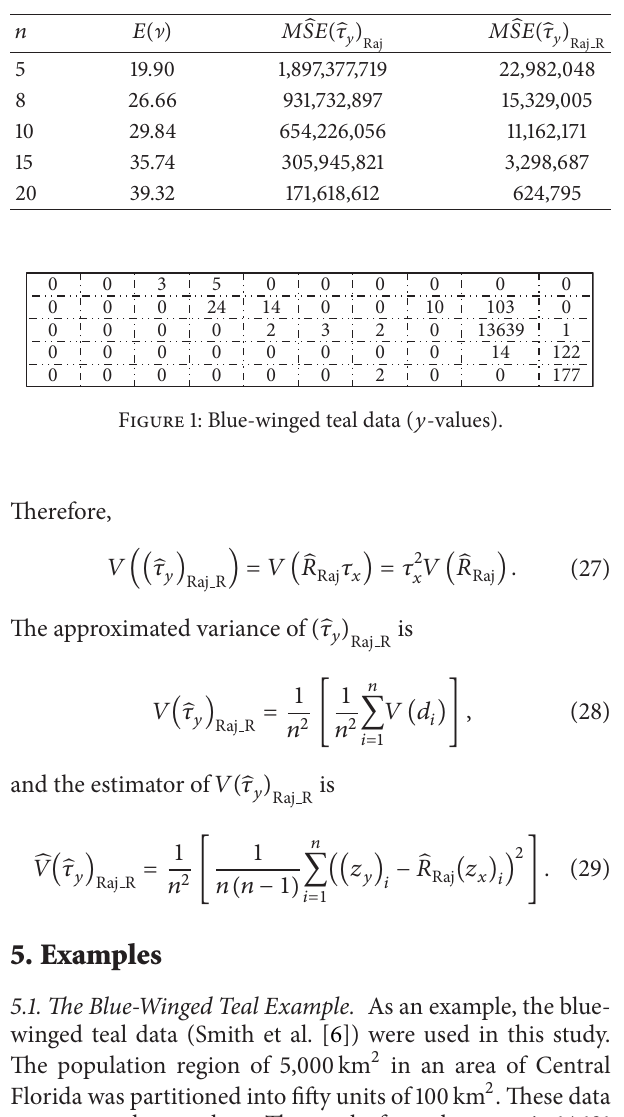
Table 2: The estimated MSE of the modified Des Raj estimators for the population total of blue-winged teal.